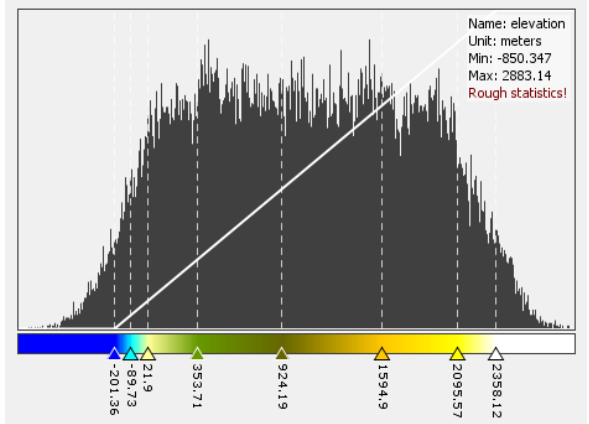
Figure 13. Histogram and Color Scale of the data of the Figure 7